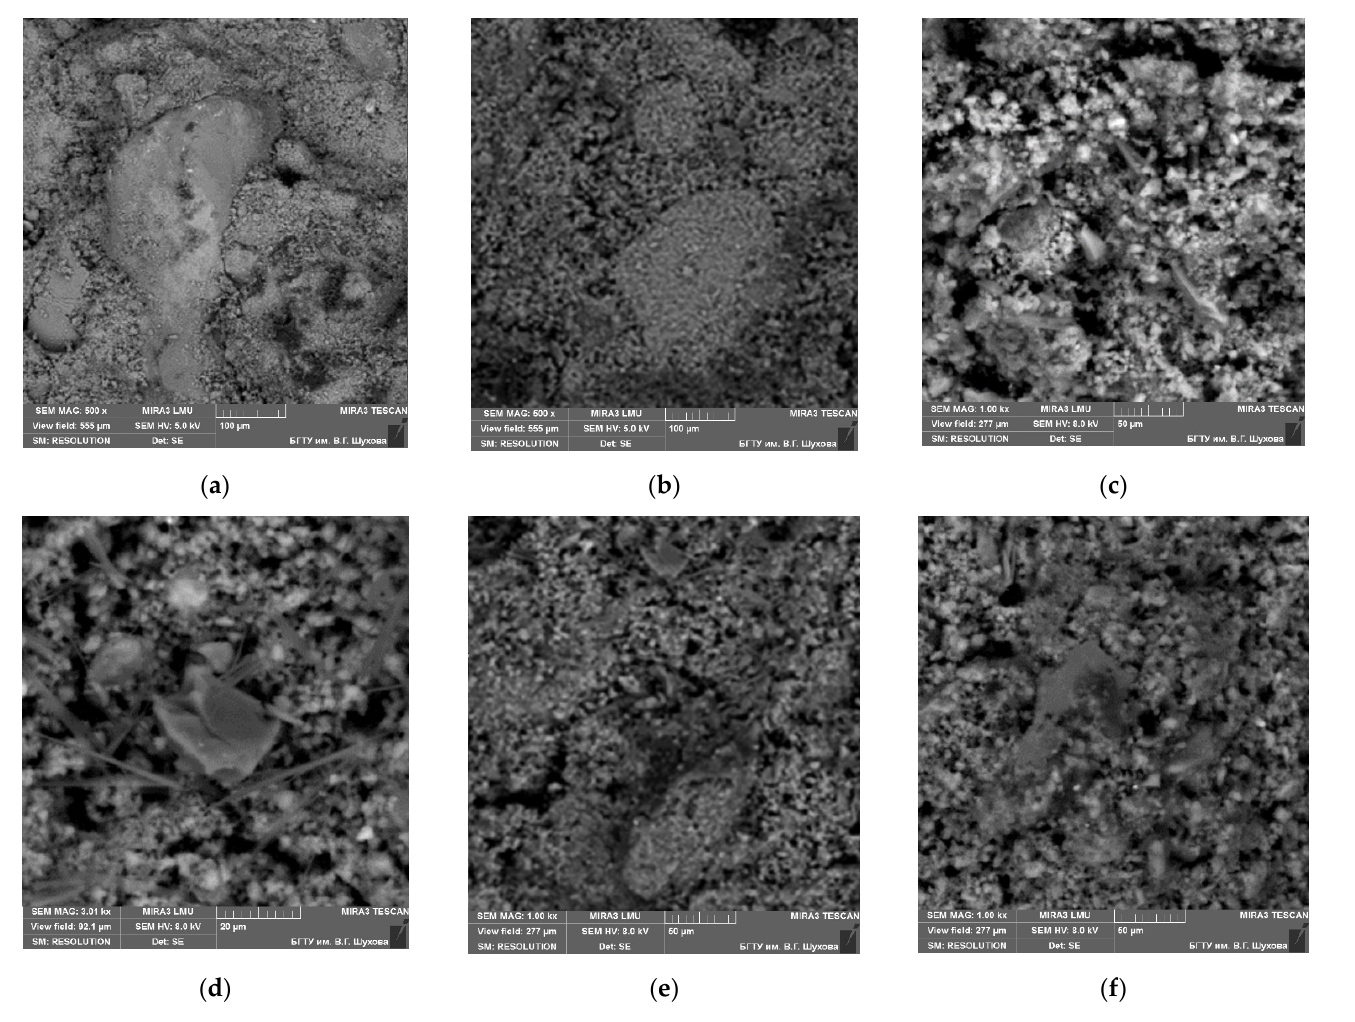
Figure 6. Microstructures of AAM with thermally treated marl (sample TM1). ( a ) Sample material structure. ( b ) Clusters of essentially calcite composition. ( c ) Typical sample microstructure. ( d ) Sodium silicate hydrates. ( e ) Microcrystalline cluster coated with a film of sodium hydrosilicate. ( f ) Sodium silicate hydrates in the structure of the material.